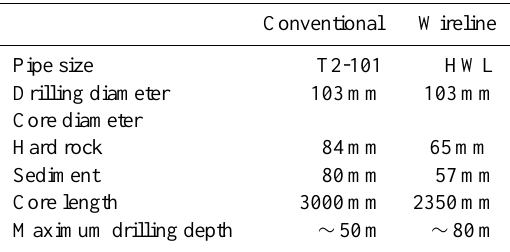
Table 2. Comparison of drill-pipe sizes used by the MeBo for con- ventional and wireline